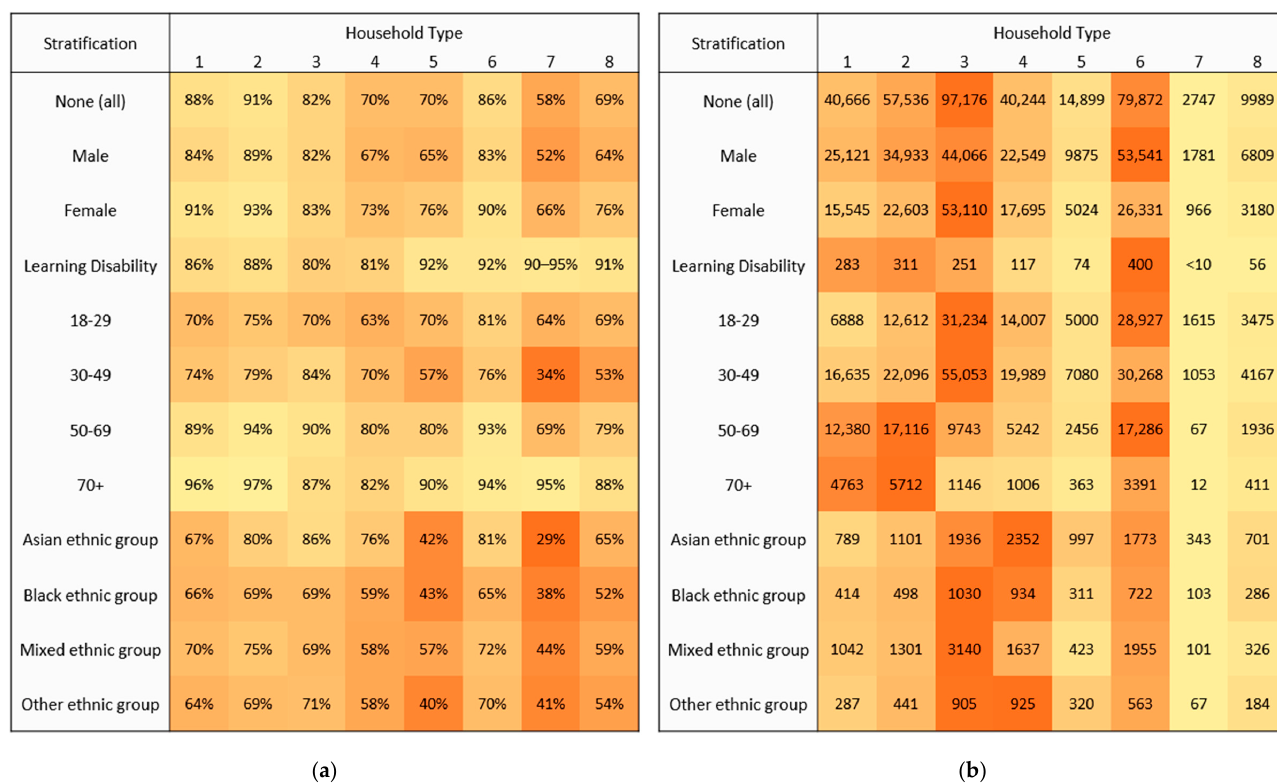
Figure 1. Vaccination with a complete two-dose course of COVID-19 vaccine (any type) by household type, stratified for sex, learning disability, age group, and Asian, Black, Mixed, and Other ethnic groups, Wales 2020–2021. ( a ) Heat map for percentage uptake with light-dark shading for higher to lower percentages across stratified categories. ( b ) Heat map for number of non-vaccinated people with light-dark shading for lower to higher numbers within stratified categories. Data sourced from the all Wales Immunisation System (WIS) in SAIL, COVID-19 Vaccination Data (CVVD), as of 1st January 2022. Ranges are given where necessary to mask low numbers.